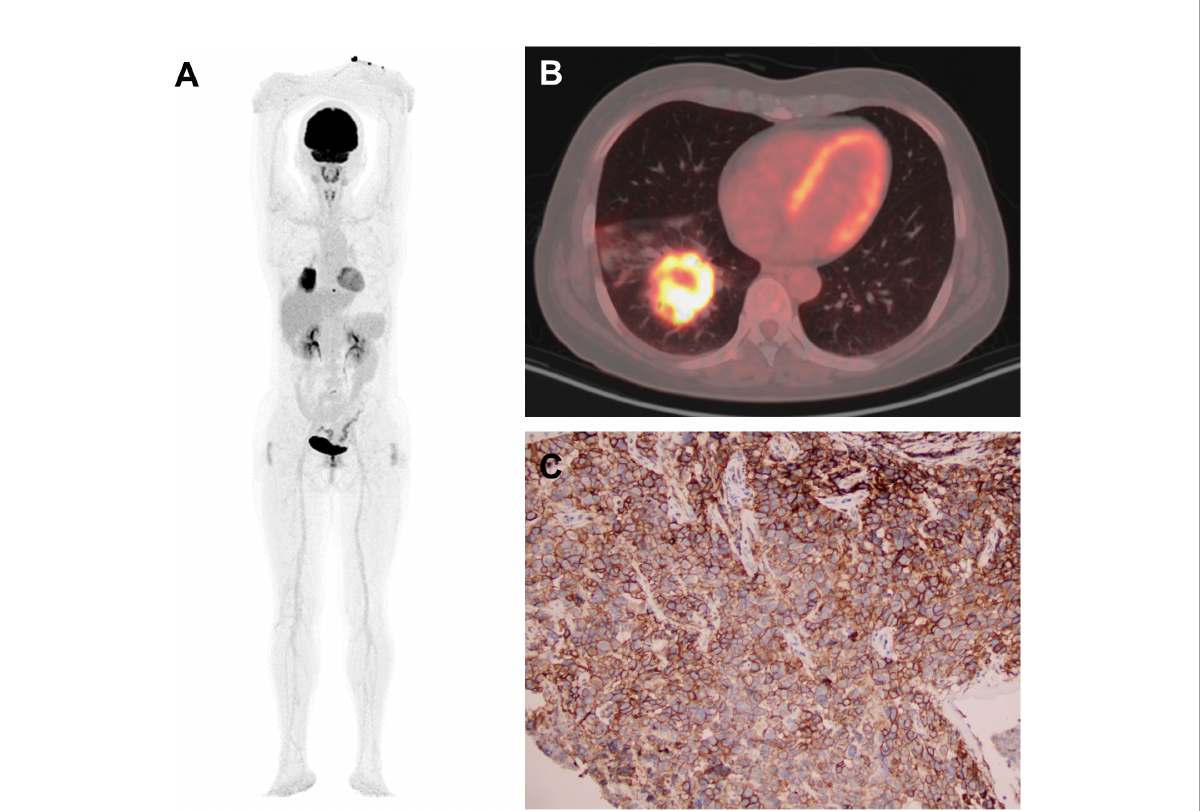
FIGURE 2 Representative of PET/CT and IHC staining: a 54-year-old female ADC patient. (A, B) PET images of MIP and CT with SUVmax 21.2, SUR-L 9.59, and SUR-BP 14.13. (C) Immunostaining image with PD-L1 expression on TCs 90% and ICs 30%. MIP, maximum intensity projection; CT, computed tomography; TC, tumor cell; IC, immune cell.